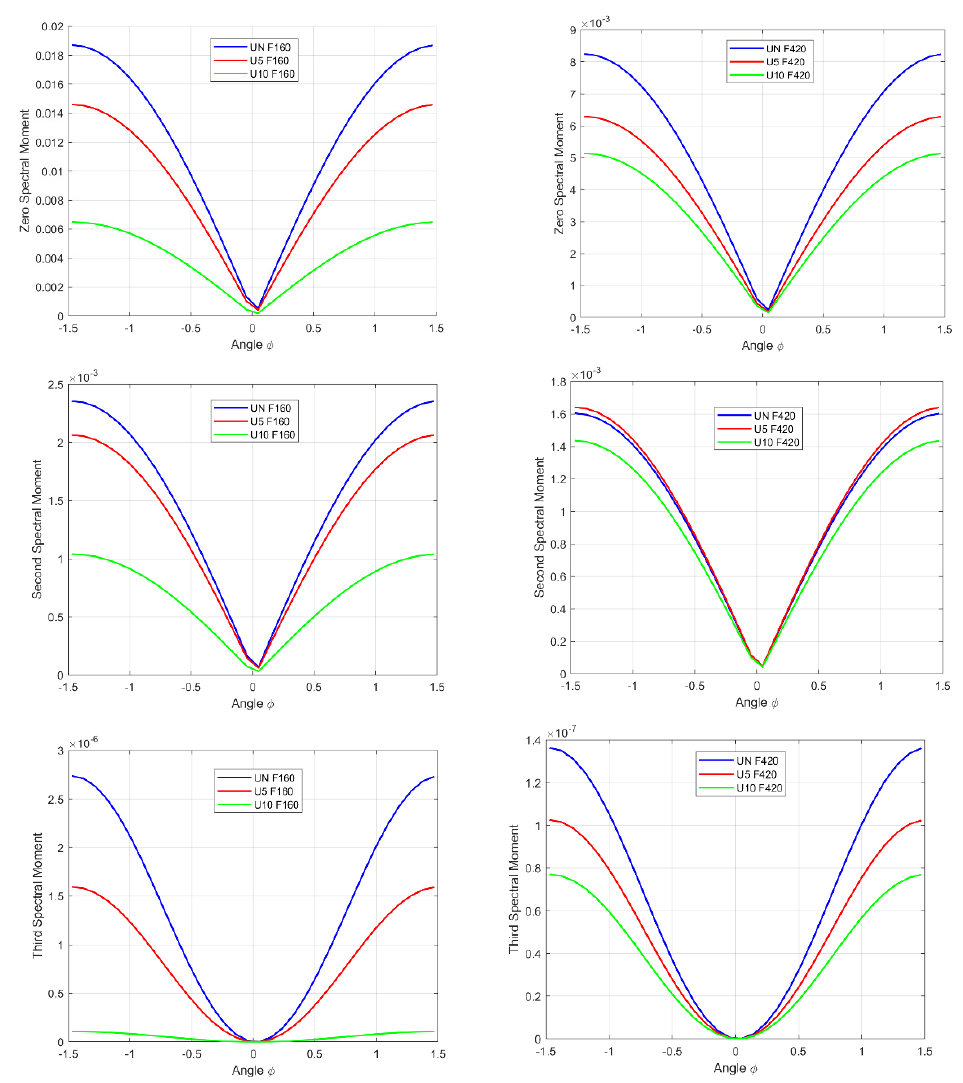
Figure 7. Spectral moments for the fractional Hilbert transform.